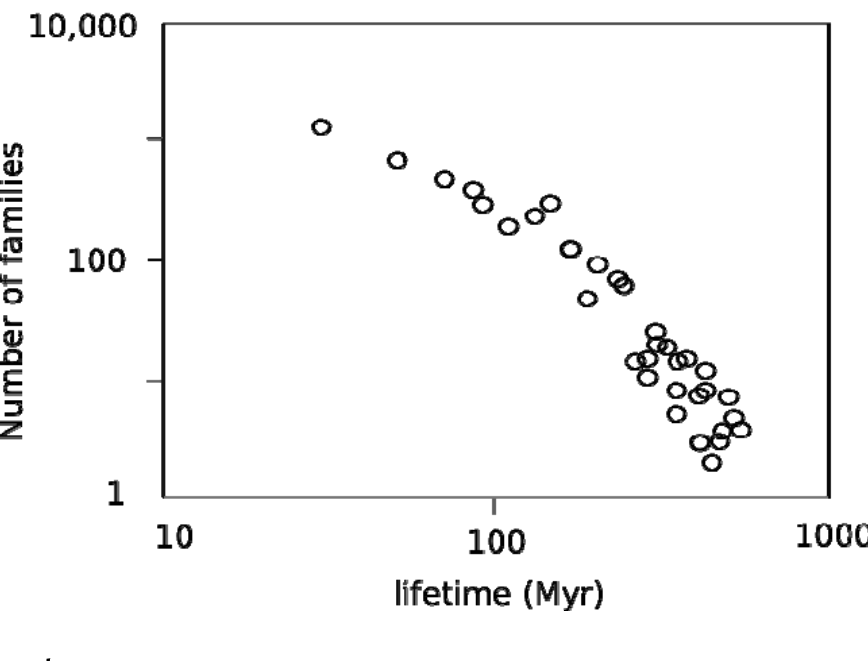
Figure 4. Lifetime distribution of families. Data from